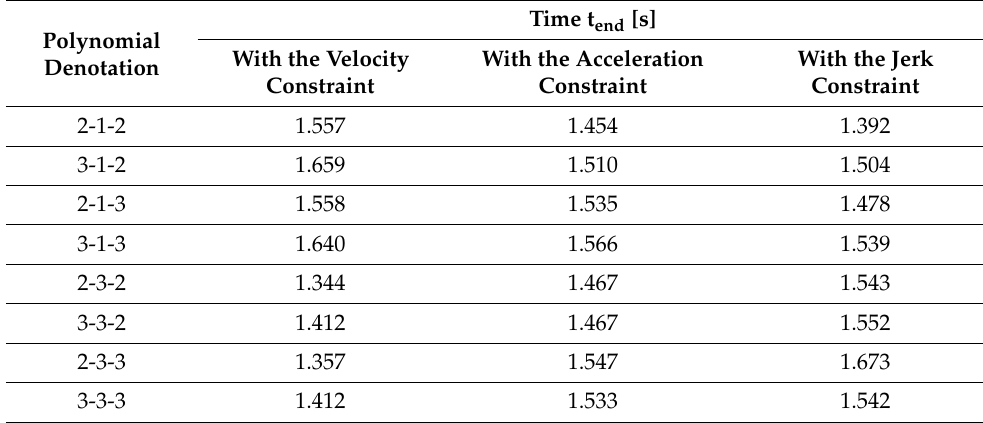
Table 3. The time of motion with the constraints of velocity, acceleration and jerk.